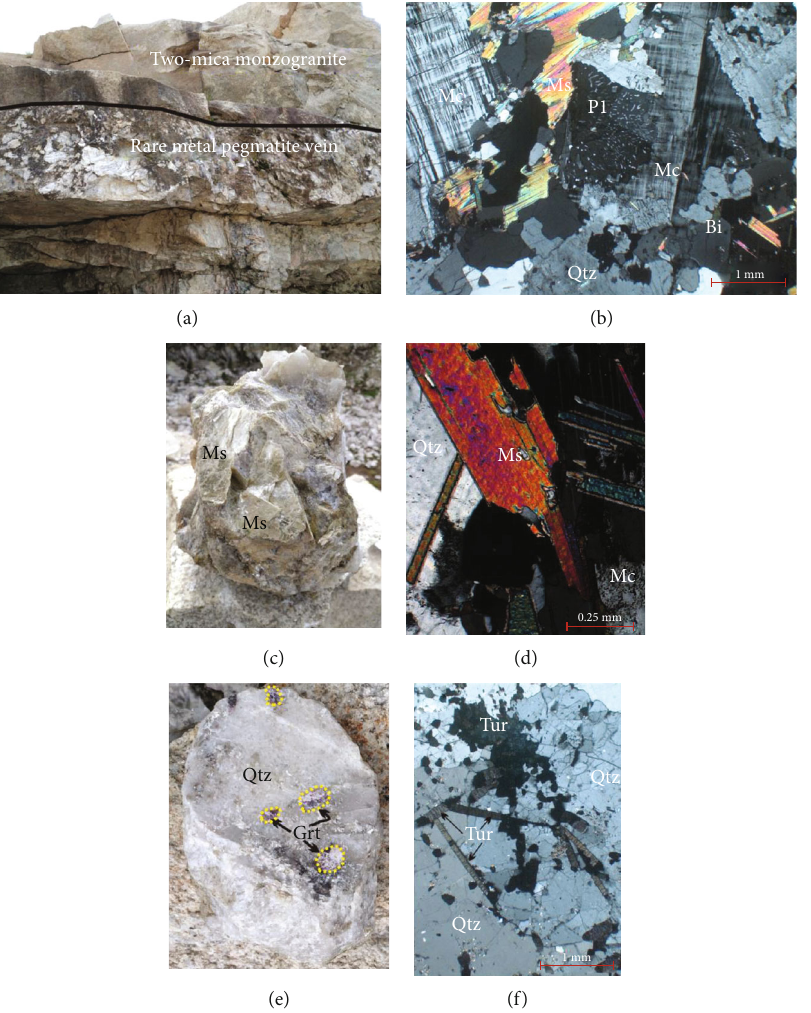
Figure 2: Field photographs (a, b) and microphotographs (c – f) of Bieyesamas monzogranite. Abbreviations: Mc: microcline; Pl: plagioclase; Qtz: quartz; Ms: muscovite; Bi: biotite; Tur: tourmaline; Grt: